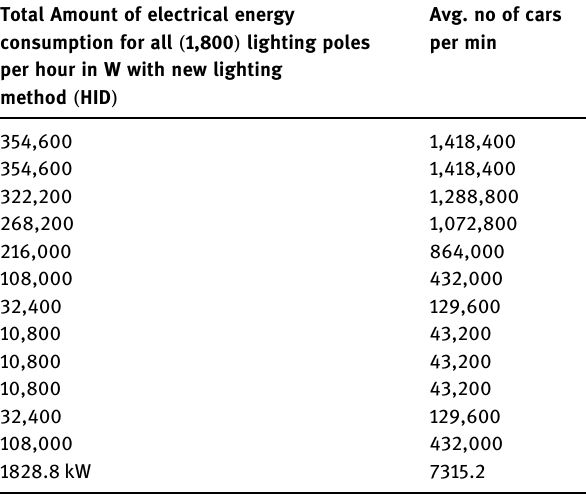
Table 3: Amount the energy consumption per pole for each hour by using the ( CLS ) methodology for HID lighting source